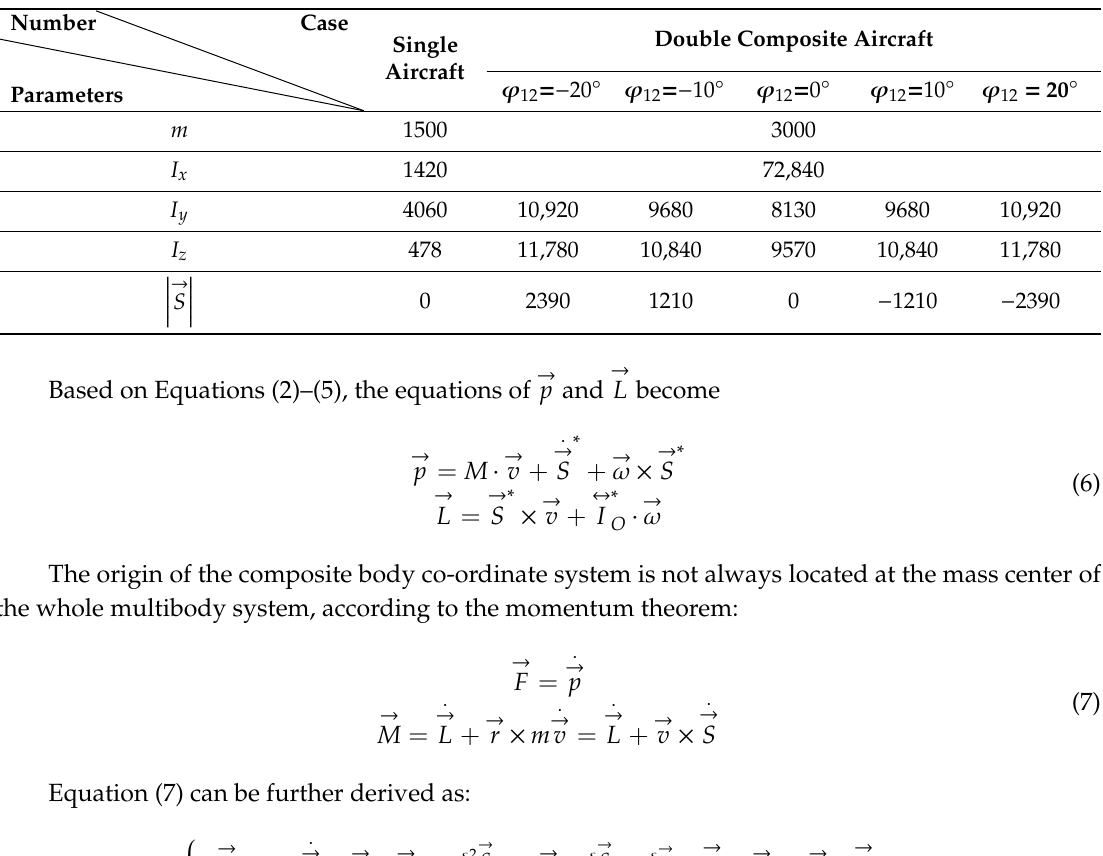
Table 1. Augmented body parameters in di ff erent